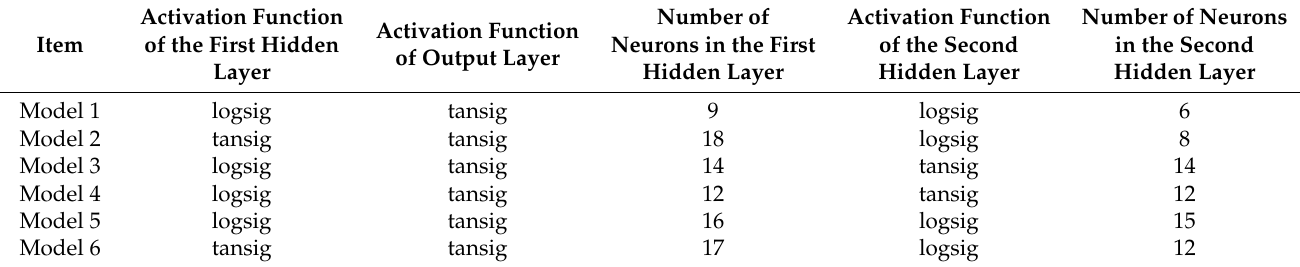
was 0.1. The number of glassy slag samples divided were 22, 20, 21, 19, 22, and 20. Then, 100 viscosity data were randomly assigned as validation and test set, respectively, and the remaining data were used as a training set to develop the BP neural network for viscosity prediction. The training functions selected for the model were all trainlm, and the other structural parameters are shown in Table 3. Table 3. Structural parameters of different prediction Table 3. Structural parameters of different prediction models.